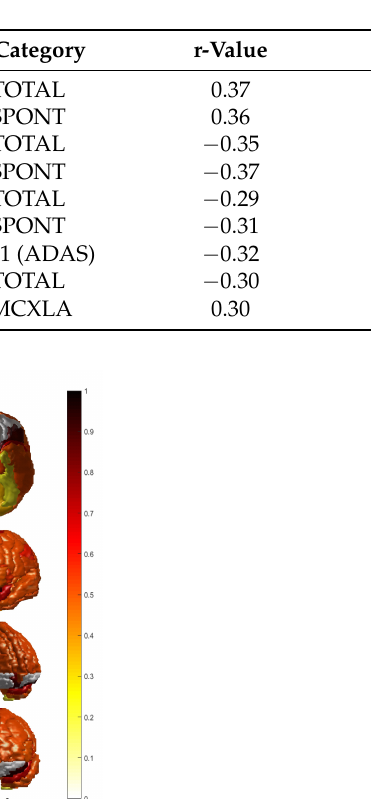
Figure 5. The comparison evaluation of our linear-based CAD system with some state-of-the-art classifiers with k-fold = 10. Table 2. The person correlation for MRI parameters and distinct behavioral tasks in MCI subjects, where: BNTTOTAL: Total number correct on Boston Naming Test, BNTSPONT: number of spontaneously given correct responses, Partial Score of BNT, TOTAL11 (ADAS): total score on the 11 item cognitive subscale of the Alzheimer’s Disease Assessment Scale (ADAS), FAQTOTAL: functional assessment questionnaire total score, CONMCXLA: number of targets hit on ADNI numbers cancellation task.